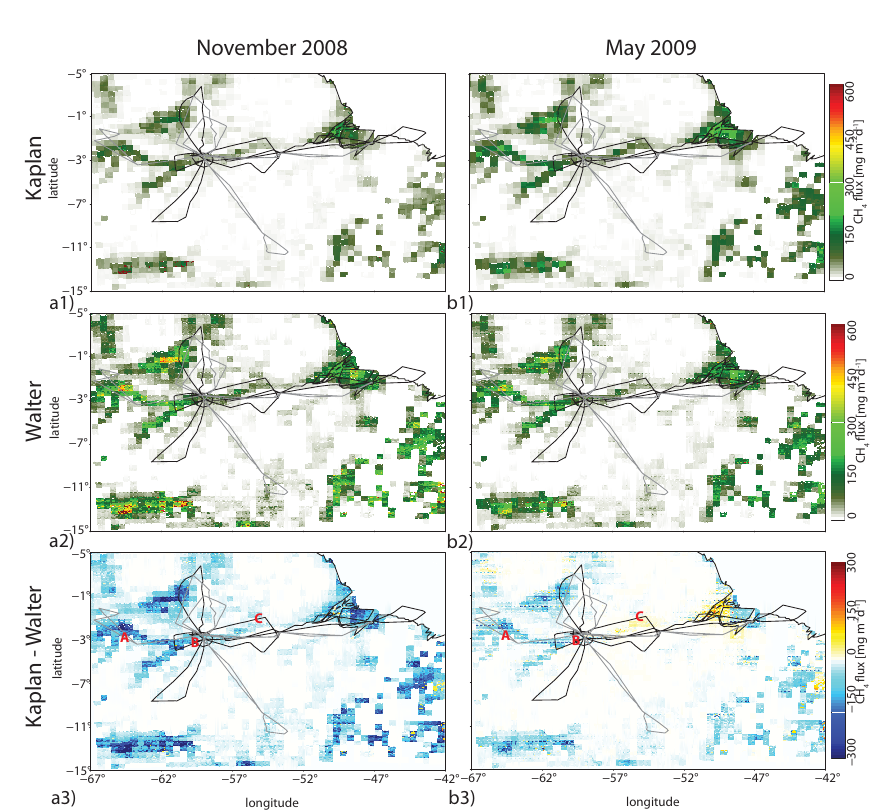
Fig. 5. Monthly mean CH 4 fluxes of the Kaplan wetland emission model (KWM) and the Walter wetland model (WWM) for the “d02” domain, both using the Kaplan wetland inundation map for November 2008 (a1–a2) and May 2009 (b1–b2) . The flux fields have already been adjusted according to the description in Sect. 4.3.3. The figures on the lower panel illustrate the difference in the CH 4 flux between the KWM and WWM for November 2008 (a3) and May 2009 (b3) . The locations of the grid cells with different wetlands types as further explained in Table 2 and Sect. 4.2 is illustrated in (a3) and (b3) with red letters (A – Manirana; B – Cabalina; C-Curu´ai). The flight track of the two BARCA campaigns is illustrated in black (BARCA-A) and grey